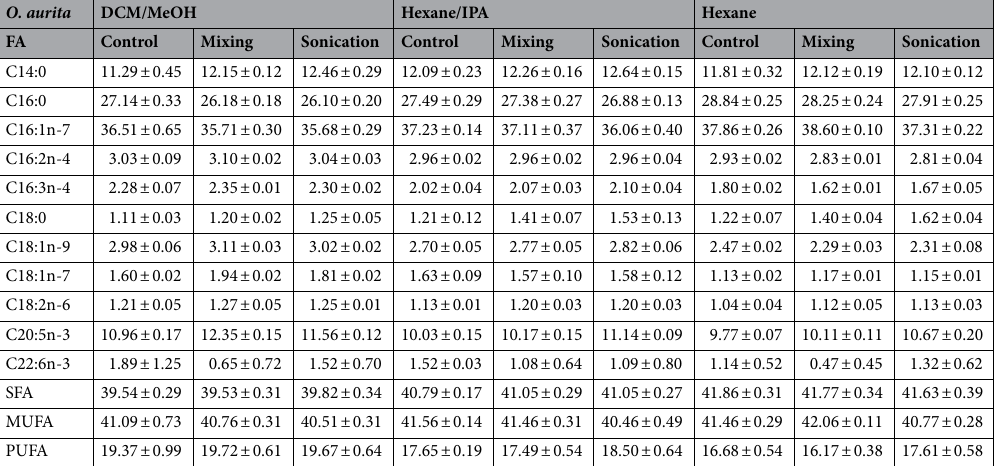
Table 3. The relative content (%) of fatty acids from Odontella aurita extracted in dichloromethane/ methanol (2:1 v/v; DCM/MeOH), hexane/isopropanol (2:1 v/v; hexane/IPA) and hexane, using three pre- treatments; no treatment (control), shaking at 1000 RPM for 60 min, (mixing), or sonication at 20 kHz for 10 min (sonication). Data shown is averages of replicates ± SD, n = 5. SFA saturated fatty acids, MUFA monounsaturated fatty acids, PUFA polyunsaturated fatty acids.